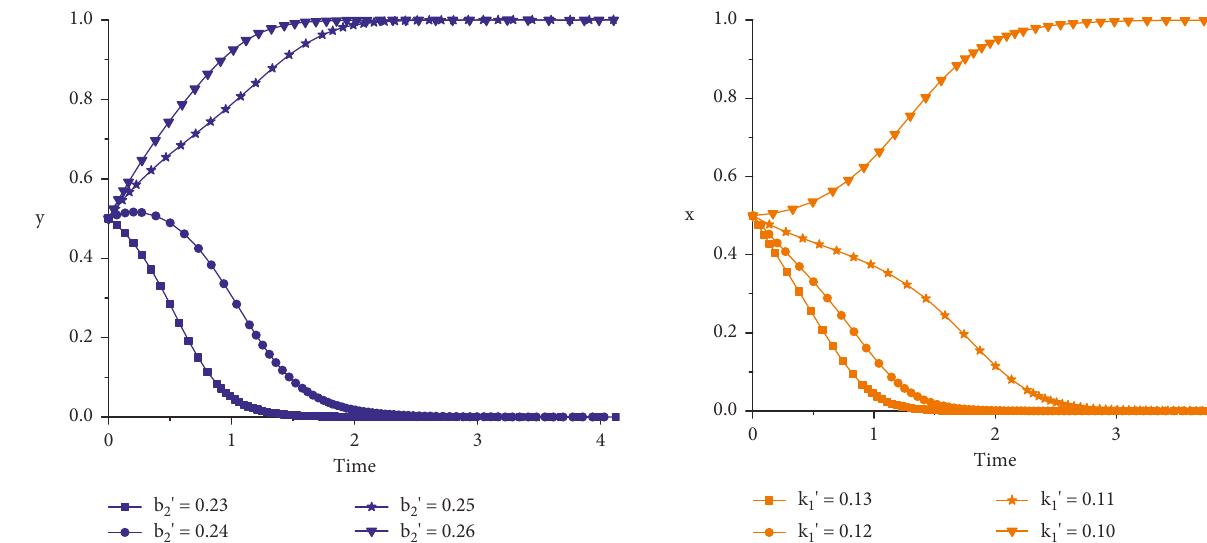
′ on enterprise 1. 1